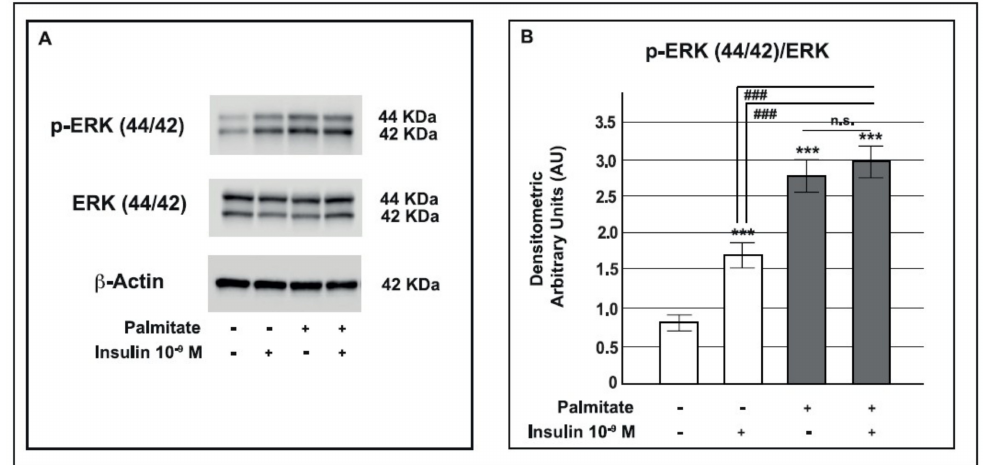
Figure 4. Effect of pre-exposure to palmitate on MAPK pathway activation in GLUTag cells. A : representative Western blot for p-ERK 44/42, total ERK 44/42 (ERK) and β -actin from control and palmitate GLUTag treated cells (0.5 mM for 24 h) acutely stimulated with insulin 10 − 9 M for 5